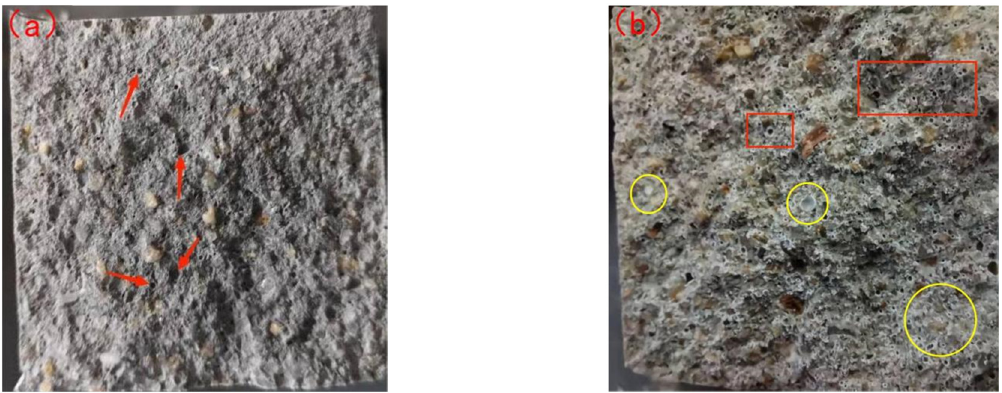
Figure 4: Classic section morphology of GOPARMs: ( a ) P0G0 group ( red arrows – pores ) ; ( b ) P5G3 group ( yellow circles: polymer fi lms and; red rectangles: air bubbles )